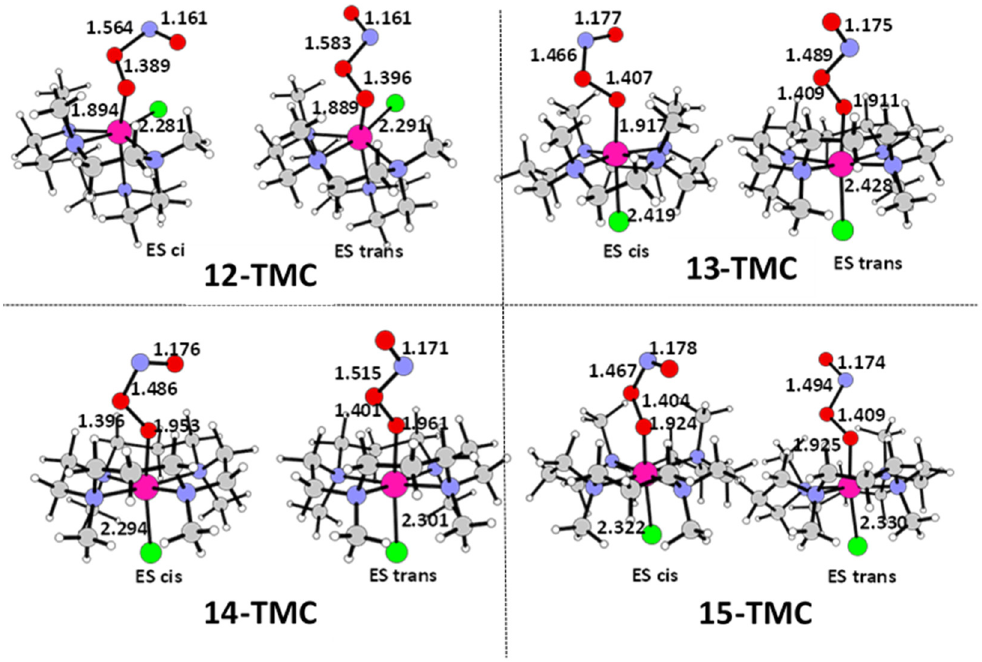
Figure 1. Optimized structures and main geometrical parameters of ES cis and trans peroxynitrite of the end-on [Cr(III)(n-TMC)(O 2 )(Cl)] + ( n = 13, 14 and 15) superoxo or side-on [Cr(IV)(n-TMC)(O 2 )(Cl)] + ( n = 12) peroxo complexes on NO. Selected bond lengths are in Å. Oxygen (red), chlorine (green), carbon (silver), nitrogen (azure), chromium (hot pink).